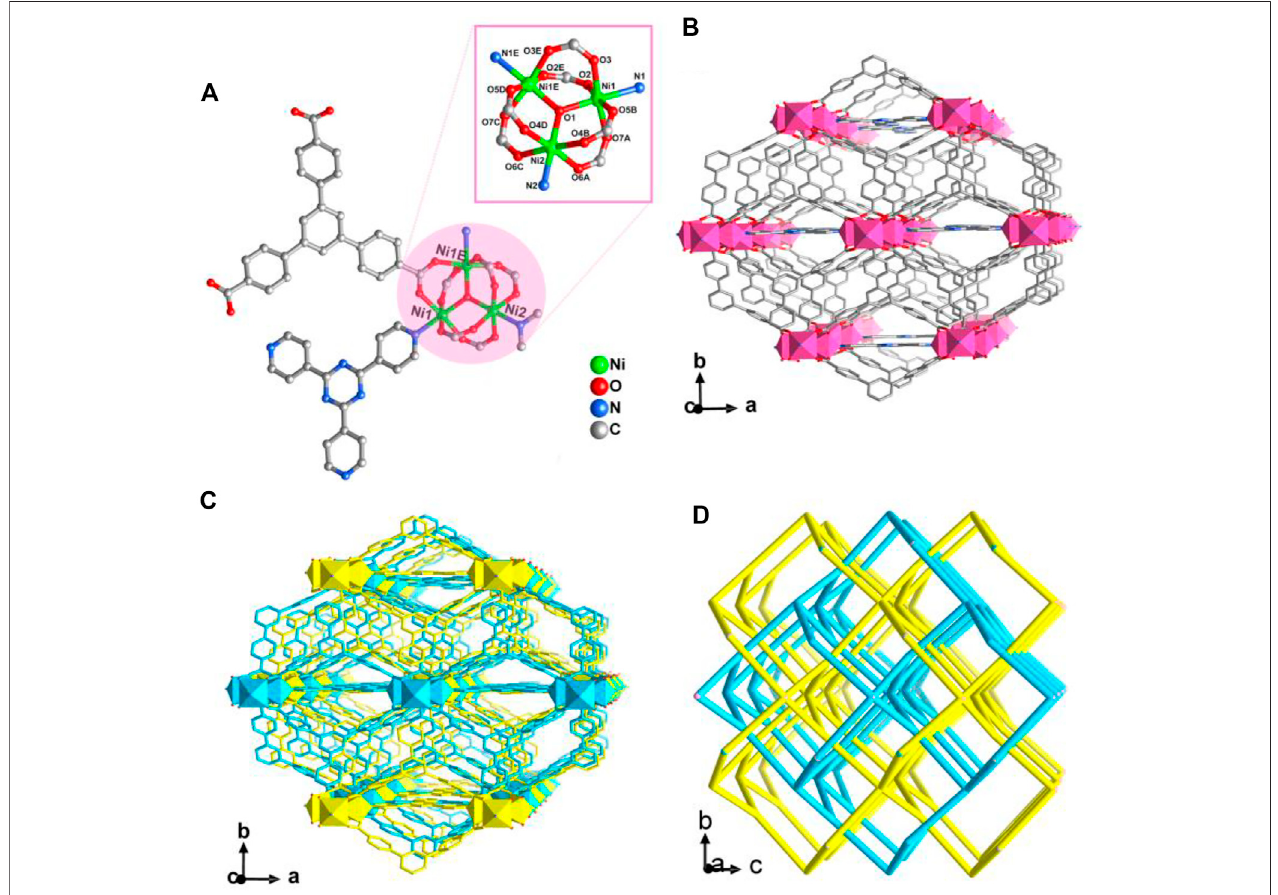
FIGURE 1 | (A) View of the [Ni 3 ( μ 3 -OH) (COO) 6 ] cluster unit in CTGU-24. The inset is the secondary building unit (SBU) of CTGU-24. (B) View of the single 3D framework of CTGU-24 along the c axis. (C) View of the two-fold interpenetrating 3D frameworks of CTGU-24 along the c axis. (D) Schematic representation of the 3D two-fold interpenetrating (3,8)-connected network of CTGU-24 (the single network is shown by cyanine and yellow